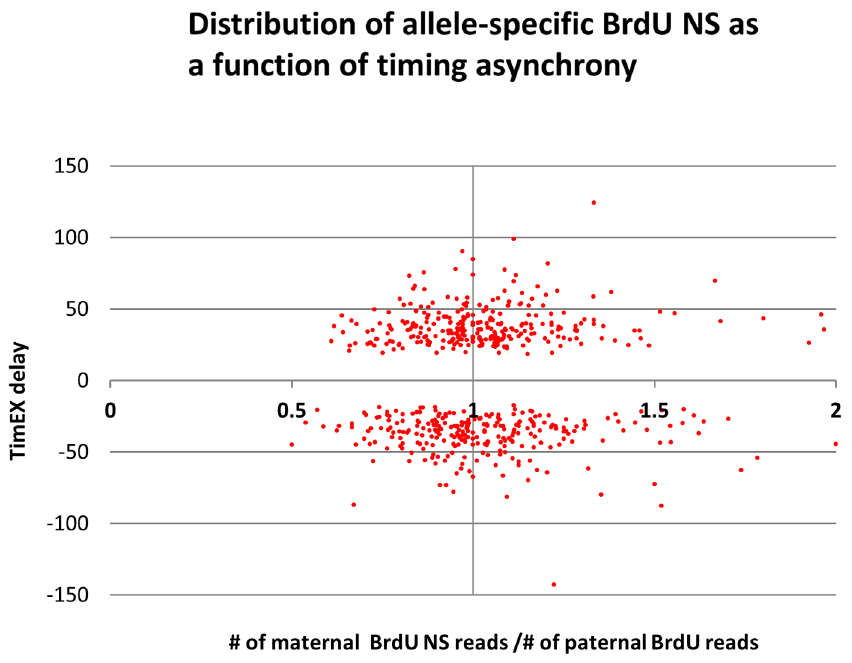
Figure 7. Distribution of allele-specific BrdU NS as a function of timing asynchrony. X-axis= # of maternal NS reads/ # of paternal NS reads. Y axis=TimEX delay S/G1 ratio of maternal chromosome - S/G1 ratio of paternal chromosome. Each point represents one of the ARD regions observed in the combined FNy01_3_2 and 3_3 data. Similar results when the data from FNY01_3_2 or 3_3 were analyzed separately or when only the top 100 significant ARD or the imprinted ARD were considered. There is no correlation between maternal and paternal TimEX differential and the density of maternal or paternal BrdU NS.